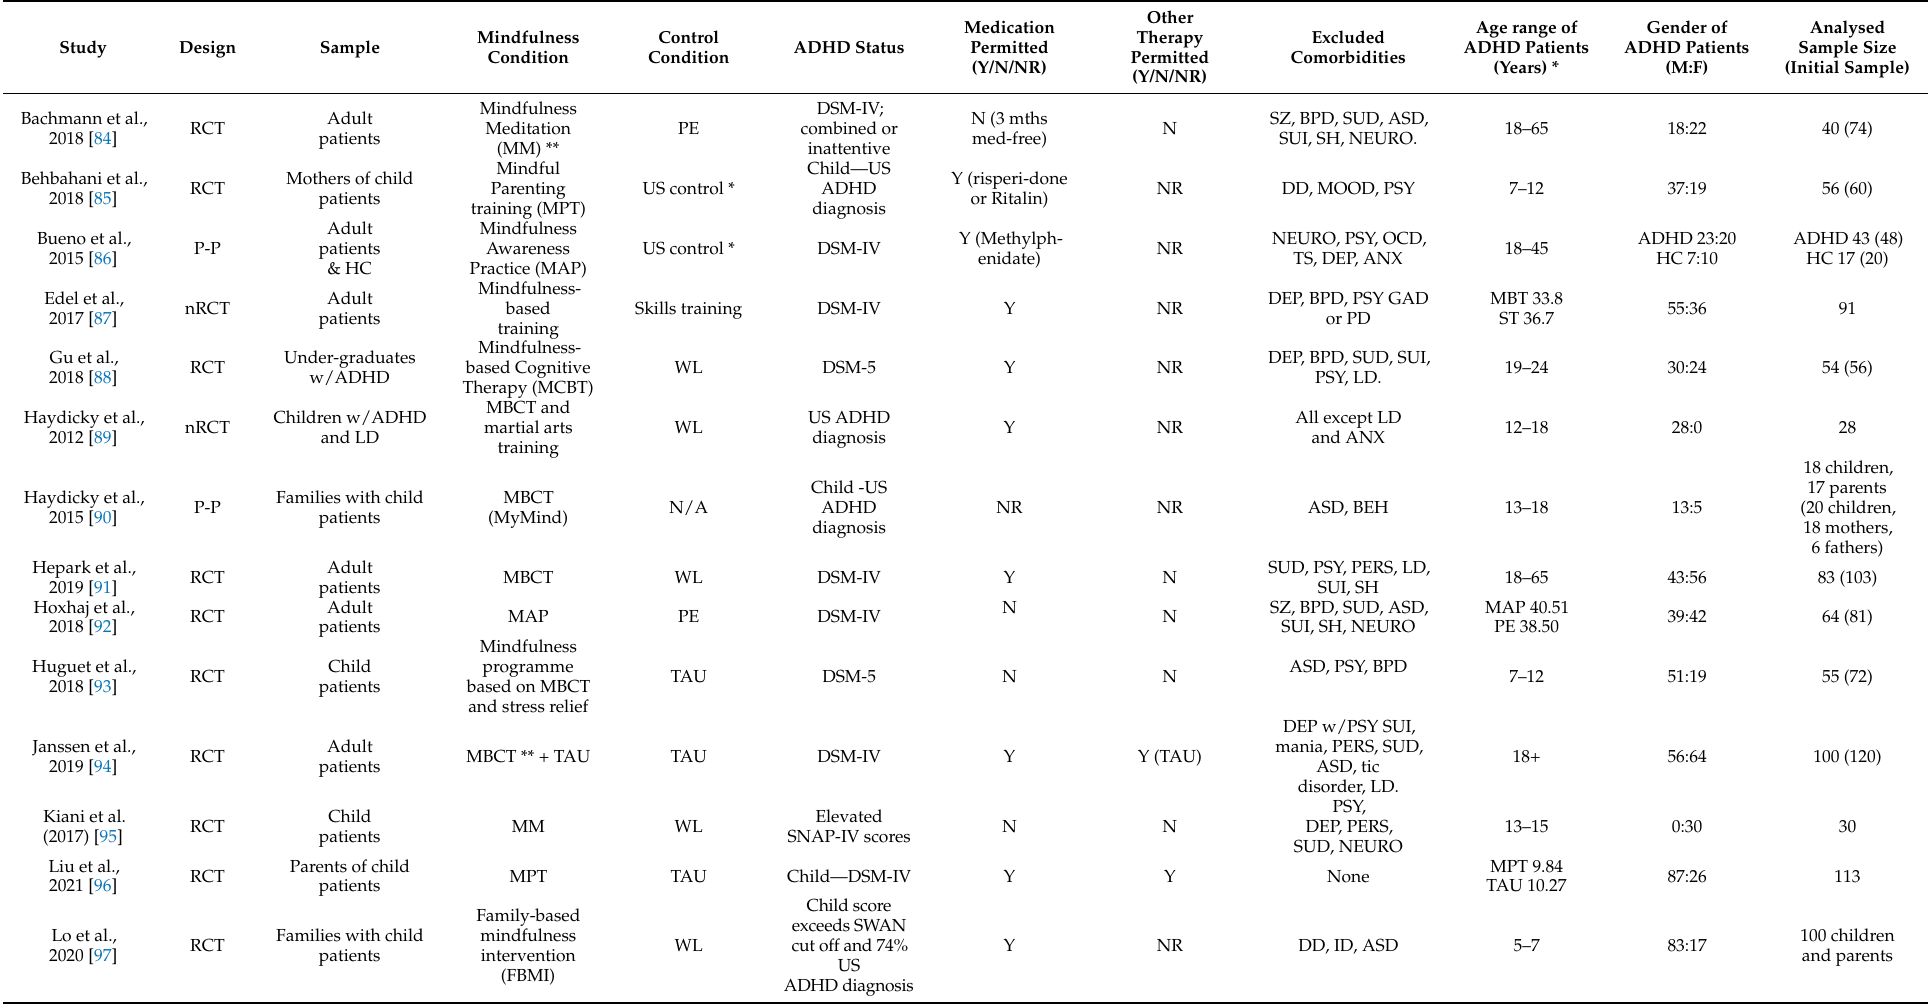
Table 1. An overview of the key characteristics of the good and fair quality studies identified for this review. Of the 29 studies identified, seven were deemed poor quality and therefore were not retained for analysis